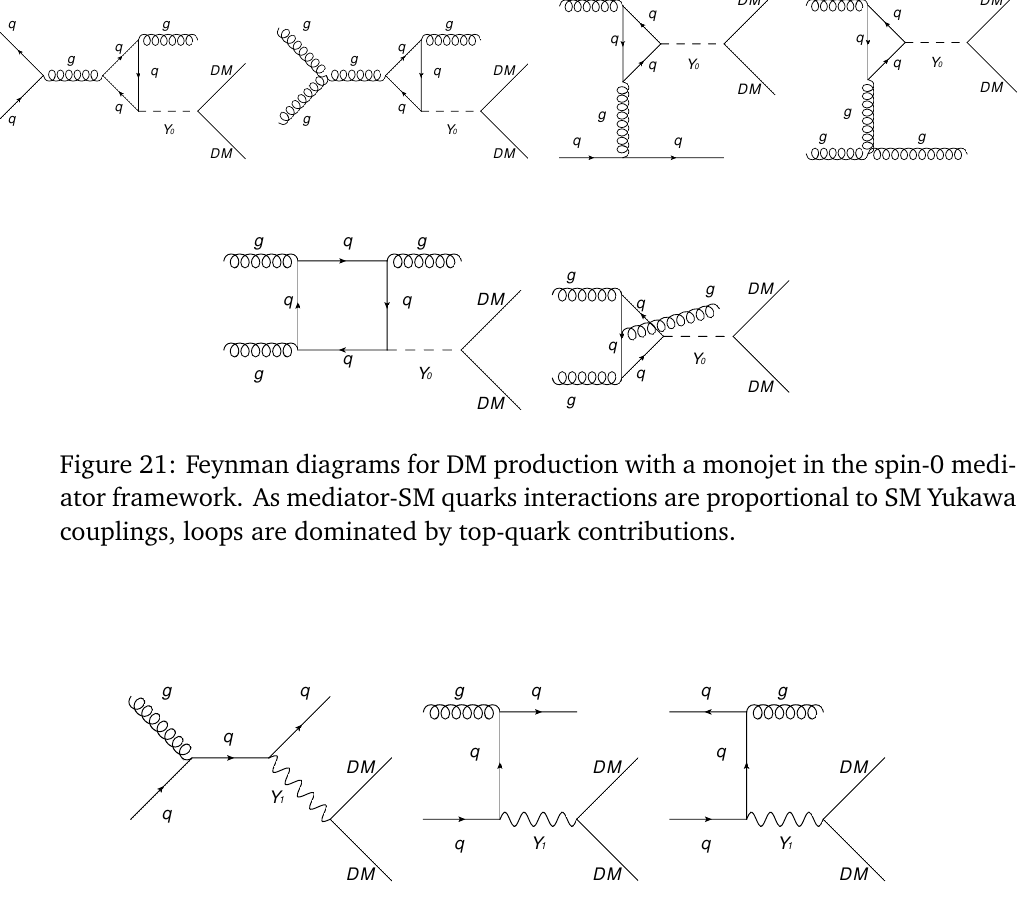
Figure 22: Feynman diagrams for DM production with a monojet in the spin-1 me- diator